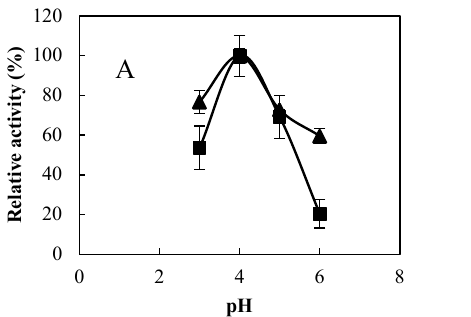
Figure 5. Effect of ( A , B ) pH and ( C , D ) temperature on the initial reaction rate of enzymes immobi ‐ lized in BGA ( A , C ) and OGA ( B , D ) using ∎ p NPG and ⯅ p NPR. 2.3. Debittering Grapefruit Juice First, the commercial enzymatic preparation (free enzyme) was used for grapefruit juice debittering. Figure 6 shows the kinetics of naringin, prunin, naringenin, and limonin concentrations. Naringin concentration decreased over time with a subsequent increase in prunin concentration, reflecting the α‐ L ‐ rhamnosidase activity. After 24 h of reaction, there was a 56% reduction in the initial concentration of naringin. Naringenin concentra ‐ tion increased after 24 h of reaction, indicating lower β‐ D ‐ glucosidase activity. Limonin was not affected by the action of the enzyme, as expected, and a 23% reduction after 24 h was observed in a control sample (data not shown), which may be explained by the de ‐ composition of the molecule.